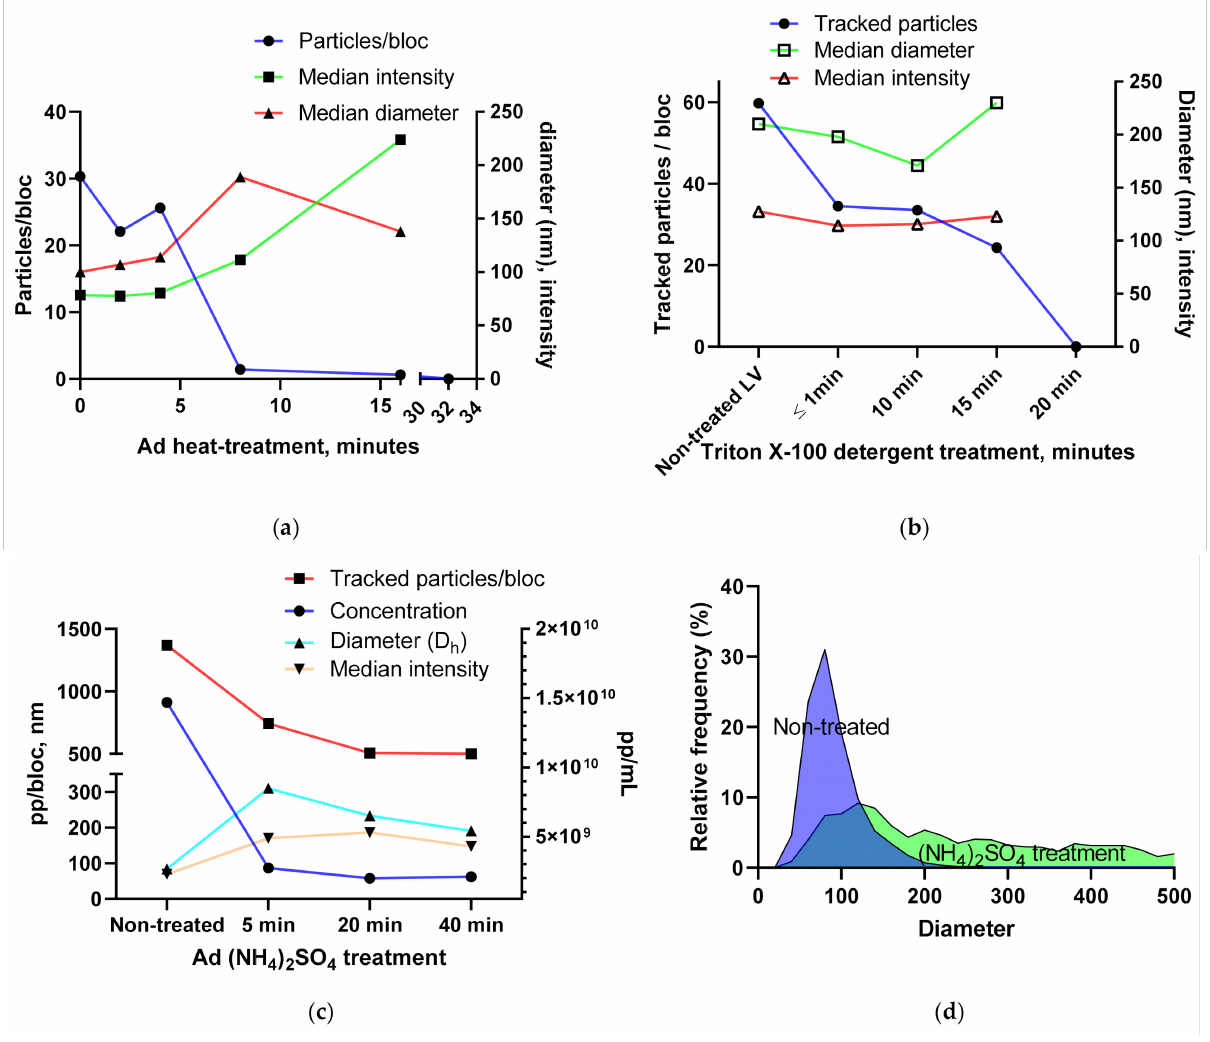
Figure 4. Virus breakage and aggregation tests using Ad and LV: ( a ) Ad heat treatment using a temperature sensitive (pIX deleted) Ad. ( b ) Lentivirus chemical inactivation using Triton X-100 treatement. ( c ) Ad aggregation test using ammonium sulfate ( d ) The change in particle diameter during the virus aggregation test. The 5, 20 and 40 min treatments were combined into a single data set for the